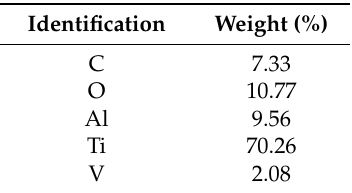
Figure 13. Energy dispersive spectroscopy (EDS) test results and SEM image of pores. Table 5. Results of EDS test of porosity.